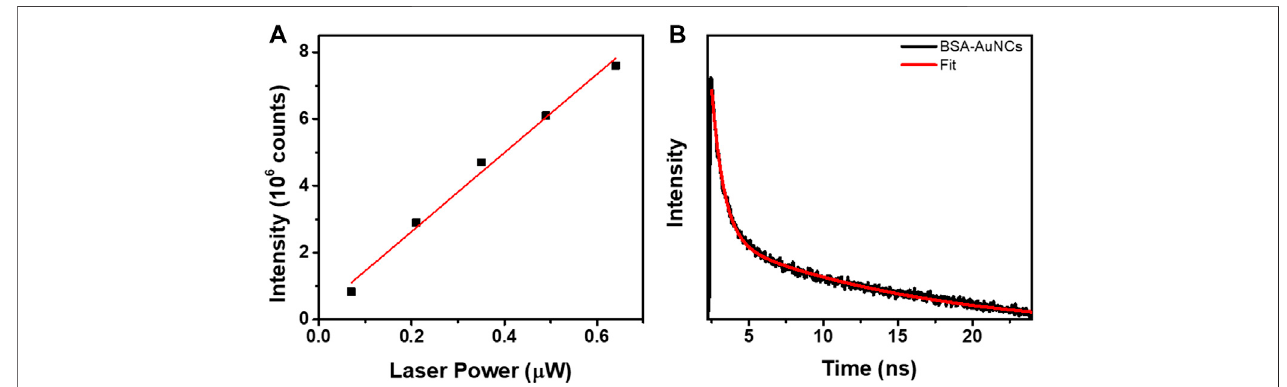
FIGURE 3 | (A) The linear dependency of the OPE PL intensity exhibited by the entire BSA-AuNCs micro fl ake on the excitation laser power (0.07 – 0.67 µW, R2 (cid:2) 0.988). (B) OPE lifetime decay corresponding to BSA-AuNCs micro fl ake under an excitation of 405 nm (0.67 µW). The intensity of the lifetime decay is presented in a logarithmic